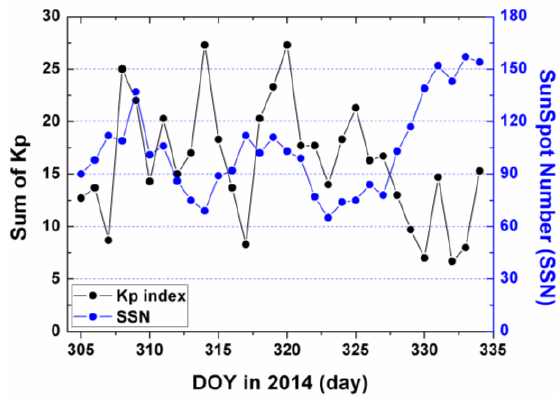
Figure 12. The STD of grid sigma of KVCE and OK in 2014.11.